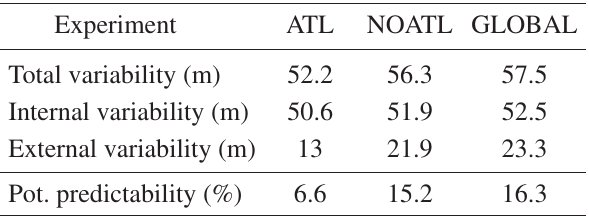
Table II. Same as in table I, but for the region NAE